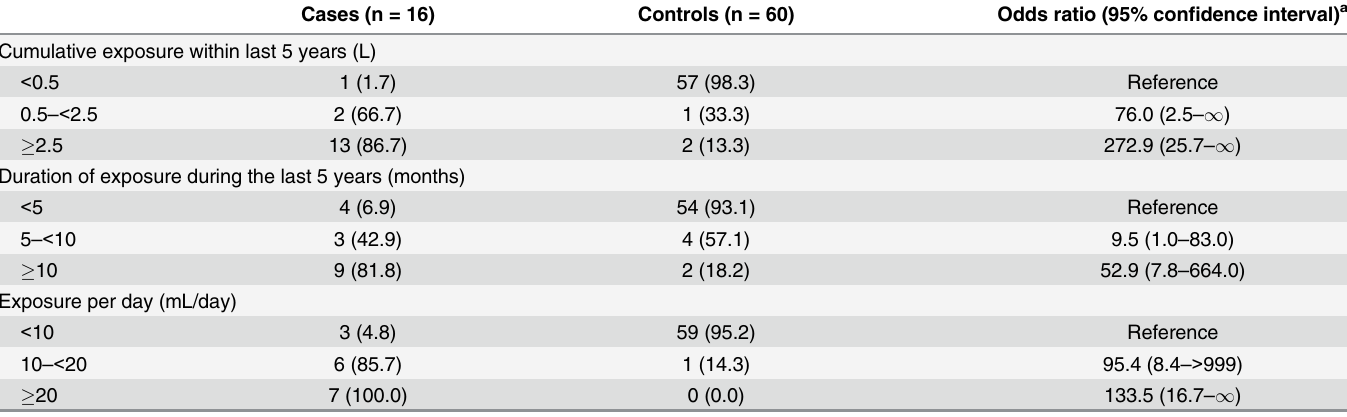
Table 3. Exposure-response relationship between humidifier disinfectants containing polyhexamethyleneguanidine phosphate and lung